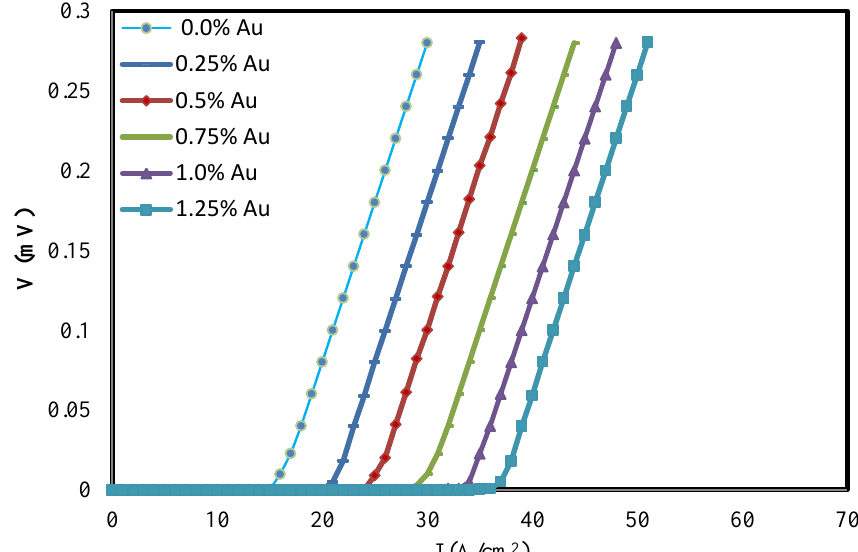
Fig. 5: Critical current density of (Au) 0.5, 0.75, 1.0 and 1.25